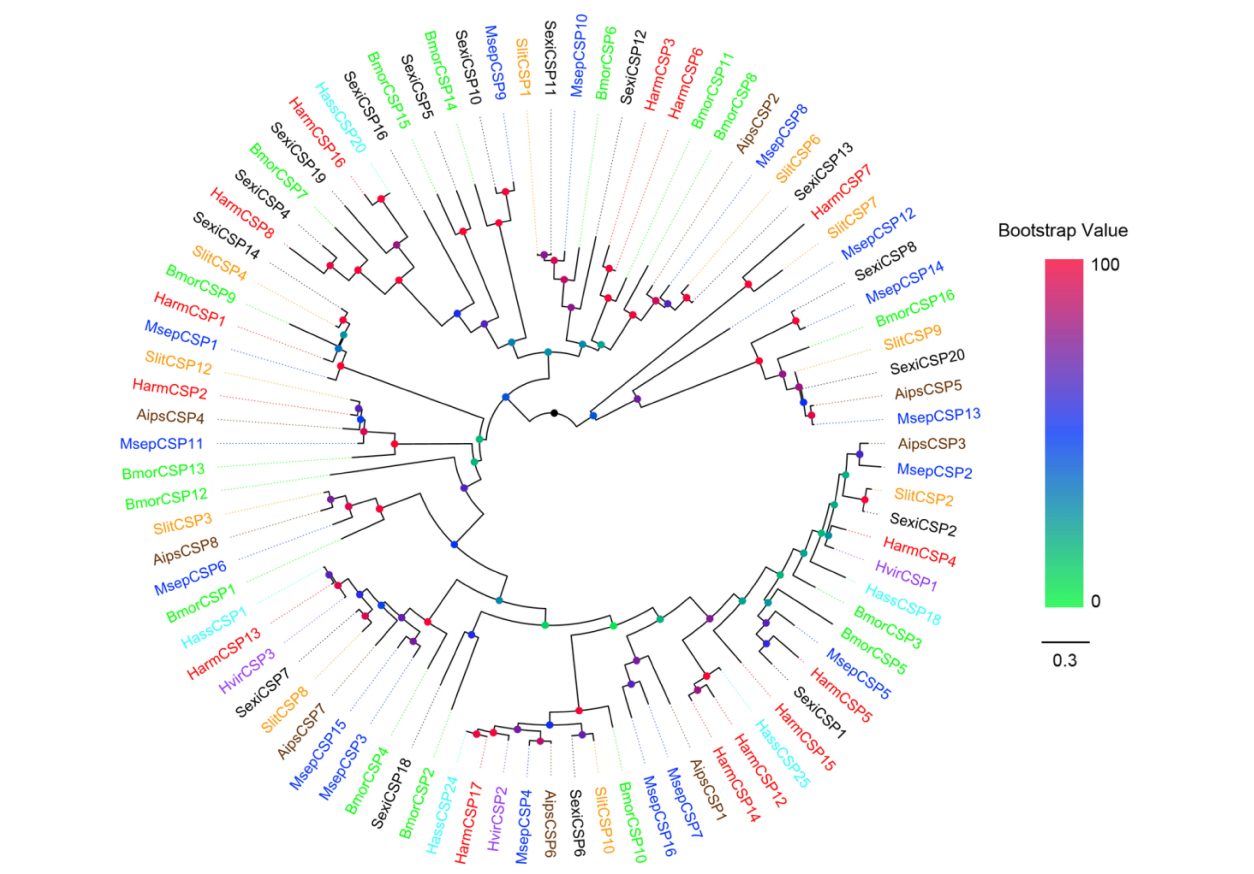
FIGURE 6 | Phylogenetic tree of putative CSPs from lepidopteran species. This tree was constructed using MEGA5.2 based on alignment results of MAFFT. Msep: Mythimna separata (blue); Aips: Agrotis ipsilon (brown); Harm: Helicoverpa armigera (red); Hvir: Heliothis virescens (dark orchid); Hass: Helicoverpa assulta (cyan); Bmor: Bombyx mori (green); Slit: Spodoptera litura (orange); Sexi: Spodoptera exigua